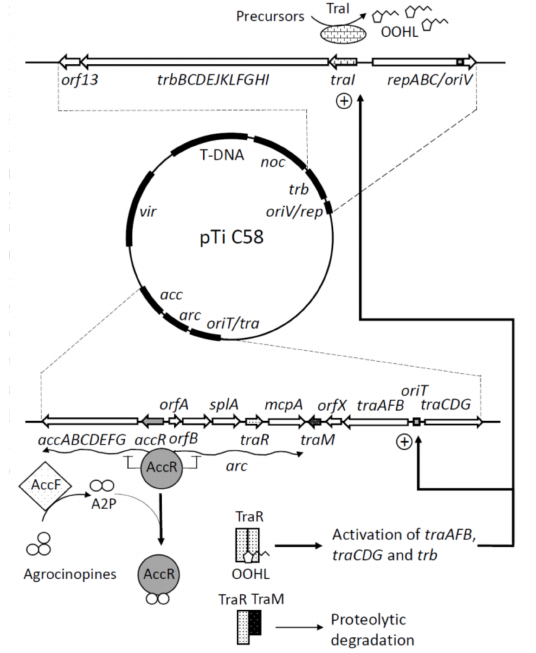
Figure 1. Global scheme of tumour inducing (Ti) plasmid organization and conjugation functions. The global organization of the C58 Ti plasmid is shown with magnified regions involved in Ti